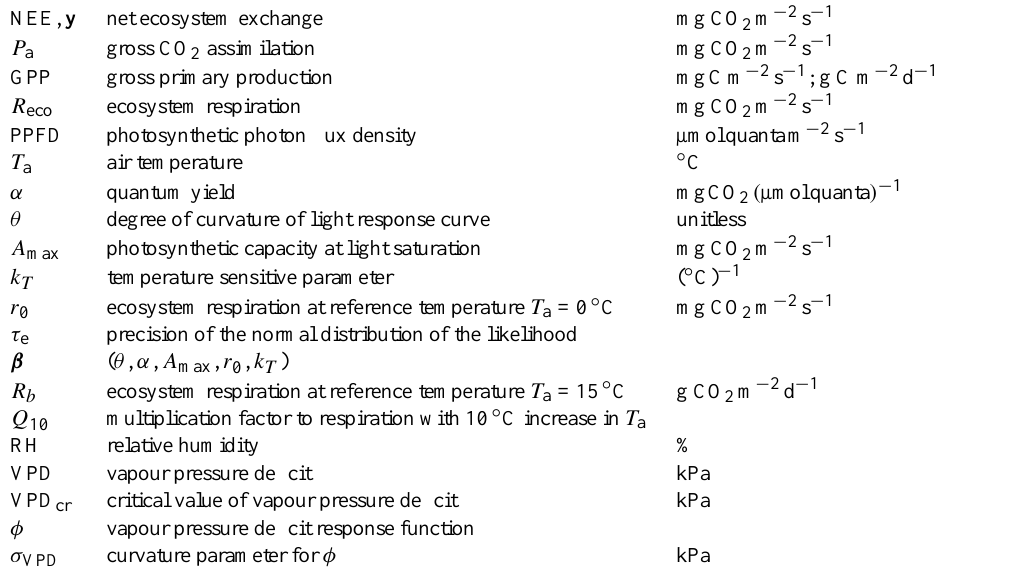
Table 1. List of symbols with unit. NEE,